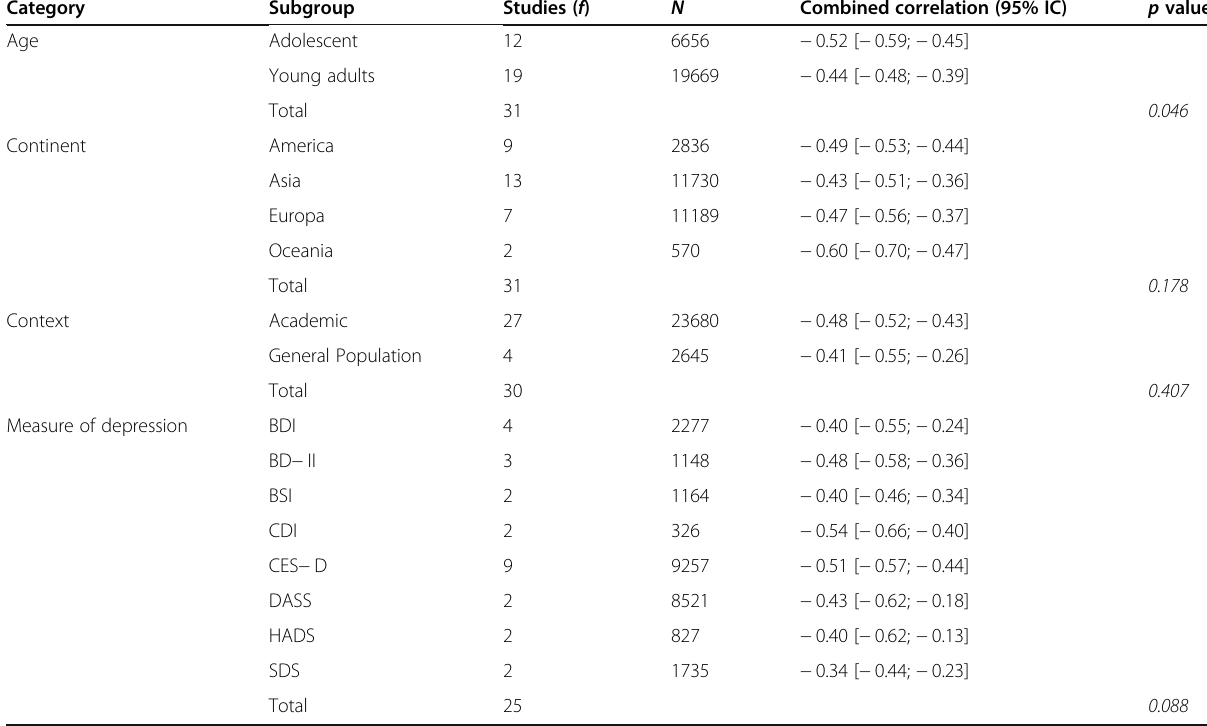
Table 2 Results of subgroup analysis